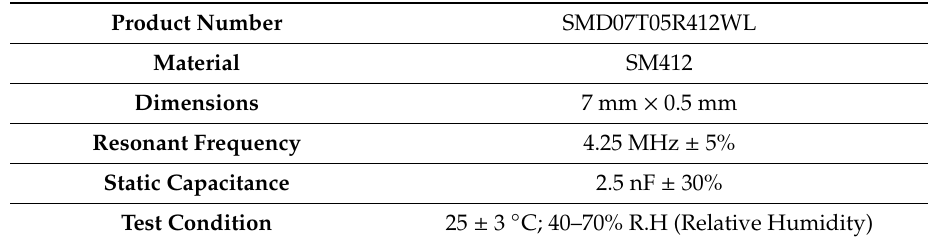
Table 1. Parameters of piezoelectric elements.